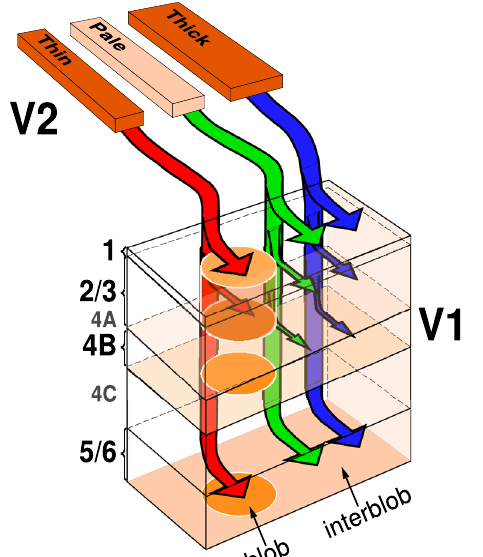
Fig. 8 Parallel V2-to-V1 feedback pathways. Our proposed model of the FB pathways from V2 to V1, based on the present study. The arrow thickness indicates the relative density of projections to the different V1 layers (L4A is omitted). For all stripe types, layers 1/upper 2 and 5/6 receive the densest FB projections, while lower L2 and L3 receive sparser projections from V2. Both thick (blue arrows) and pale (green arrows) stripes, but not thin (red arrows) stripes send FB projections to V1 L4B. FB projections from thin stripes predominantly target the V1 CO blob columns, while FB projections from thick and pale stripes predominantly target the V1 interblob